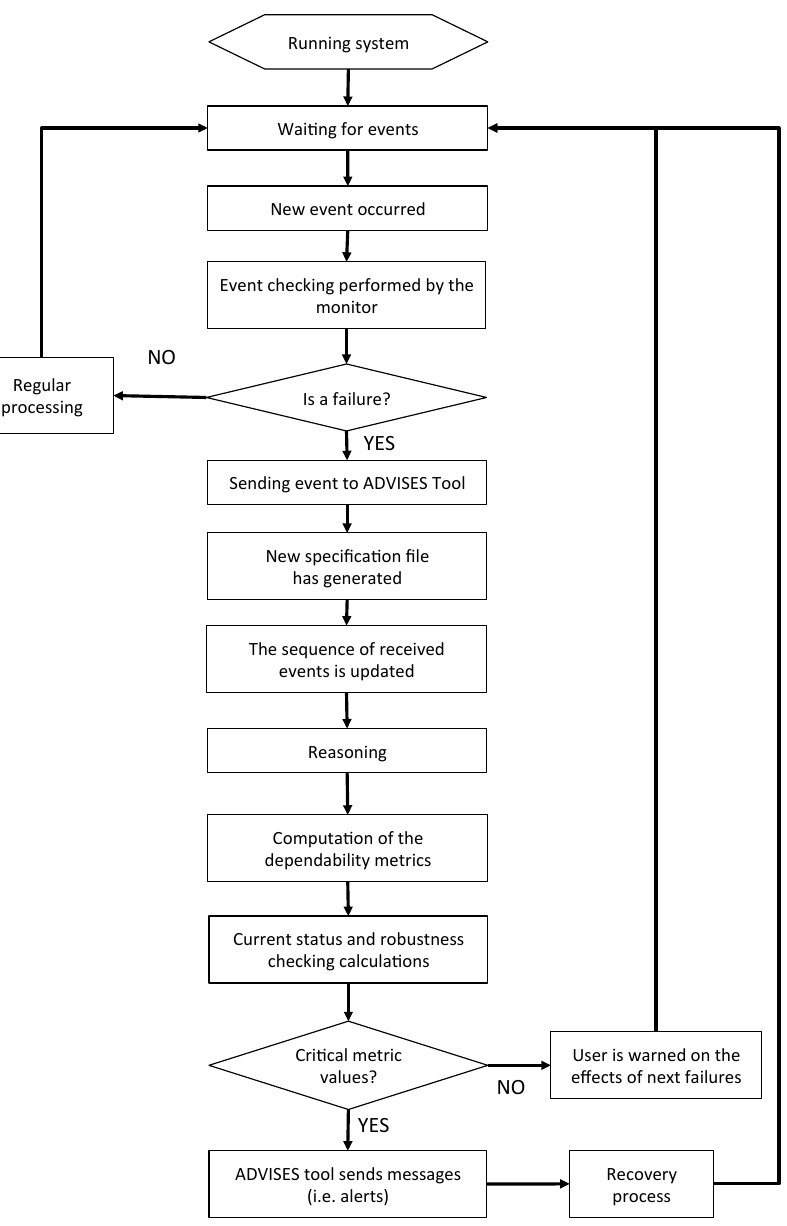
Figure 9. Runtime verification process illustrated by a flow diagram.